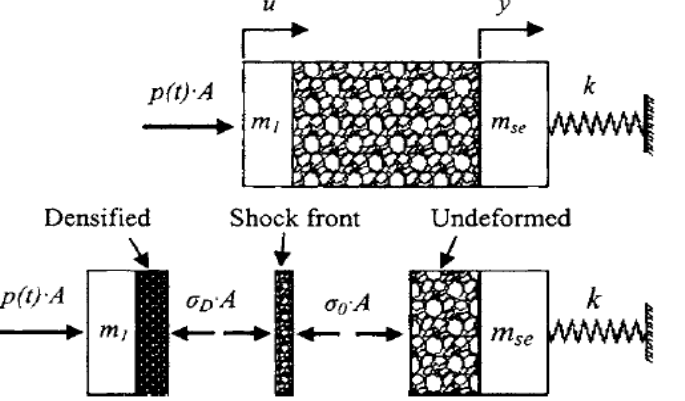
Fig. 13. Load Cladding Structural Model of Free Body